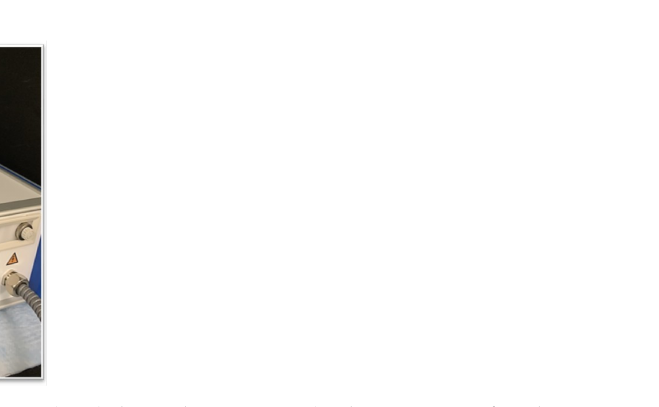
Figure 1. Low-temperature plasma (LTP) device kINPen09™ (Leibniz Institute for Plasma Science and Technology, INP, Greifswald,